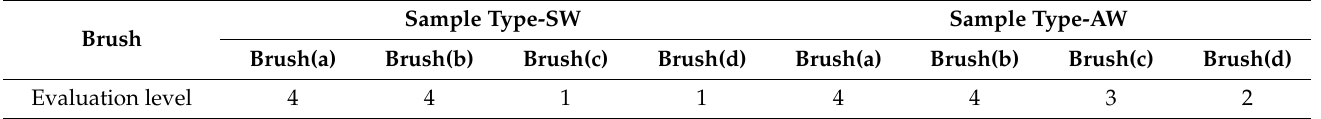
Table 10. Subjective evaluation of brushing results for four vertical micro-manipulators.